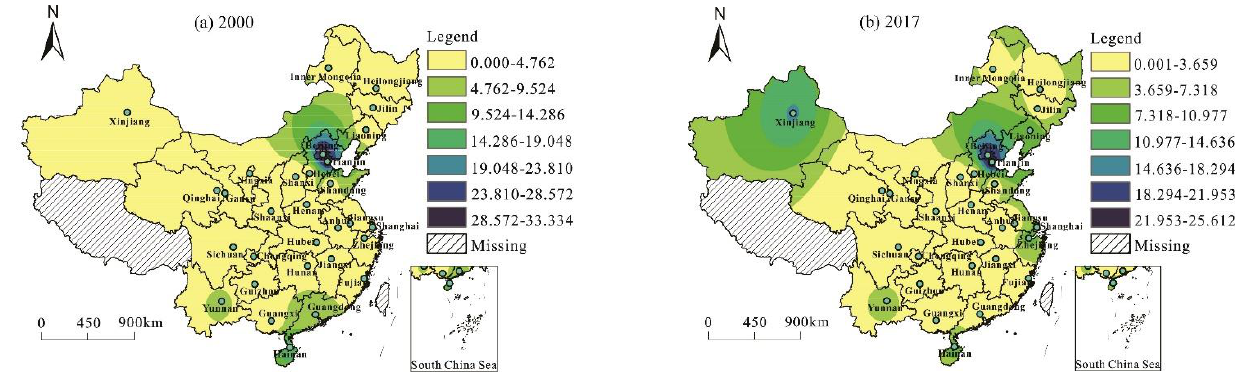
Figure 6. The spatial distribution of Betweenness centrality in year 2000 ( a ) and 2017 ( b ).